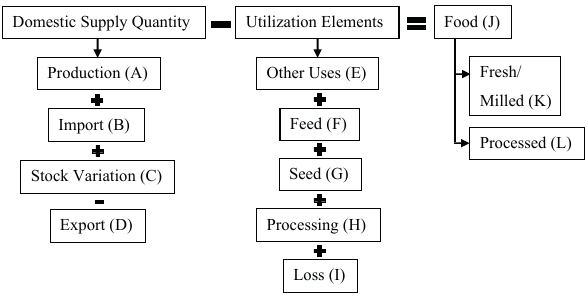
Figure 1. The mass flows model. Source: Gustavsson et al. ,